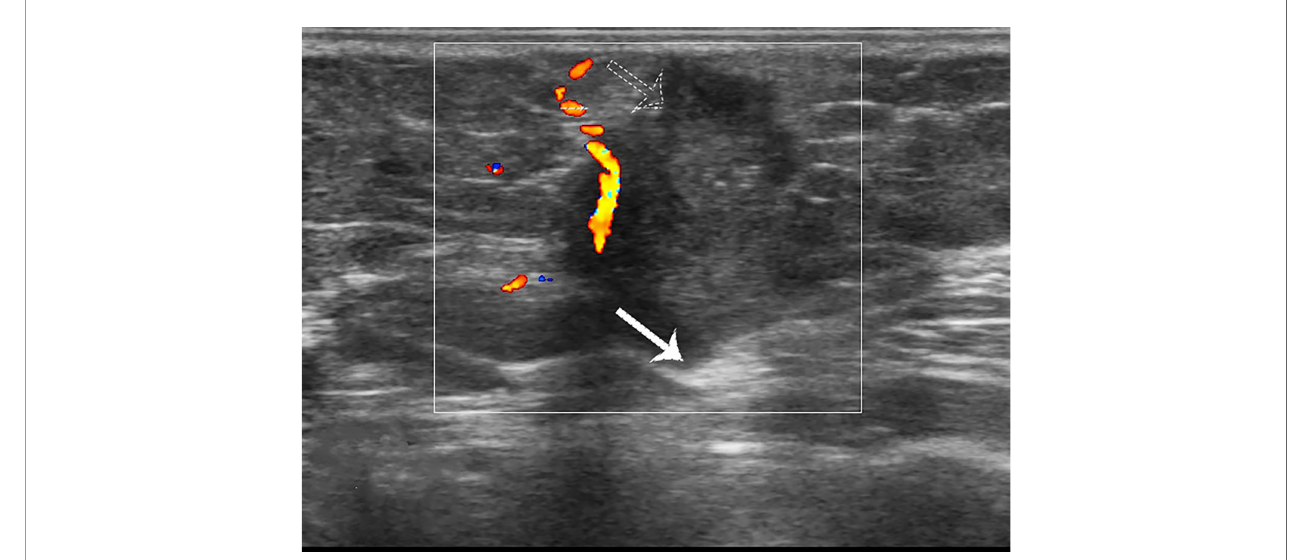
FIGURE 3 | Case 1: A 37-year-old woman with MUMPC presented with a hypoechoic mass (1.7 × 1.5 × 1.4 cm) in the left breast. Subcutaneous and retromammary fat layers were both in fi ltrated (white and dotted